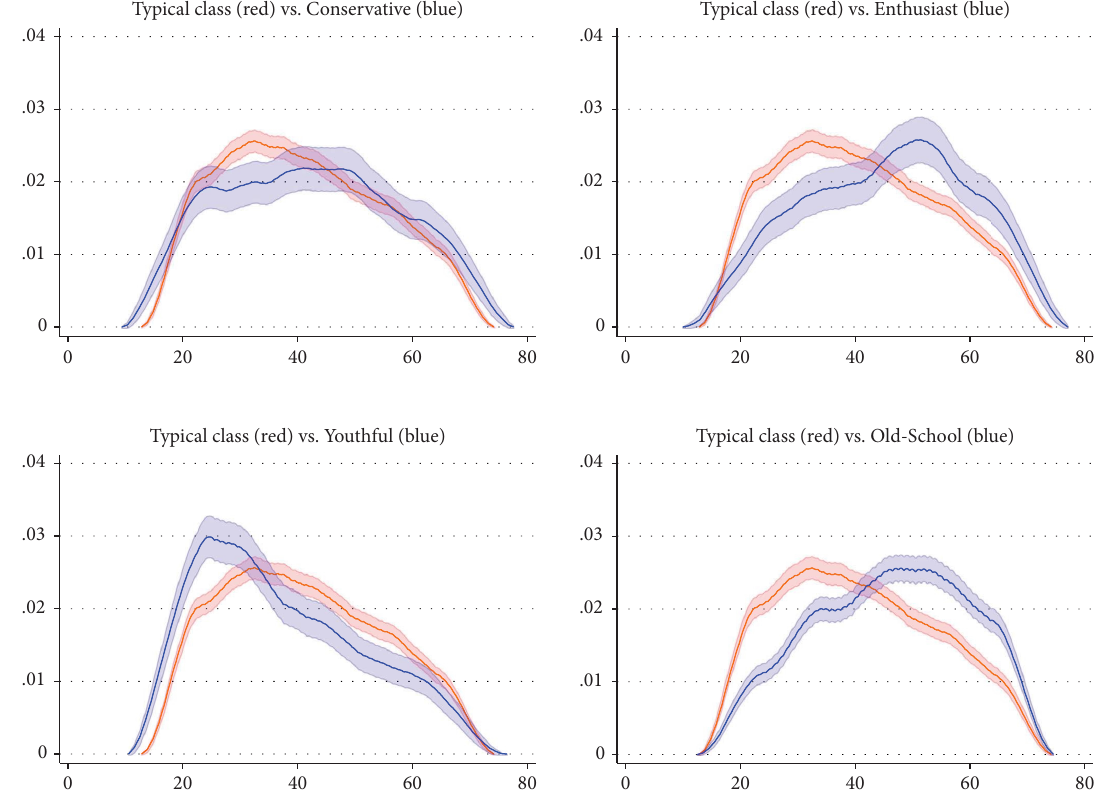
Figure 5: K-density plot of age distribution of classes of respondents. Age measured along the horizontal axis; share of respondents along the vertical